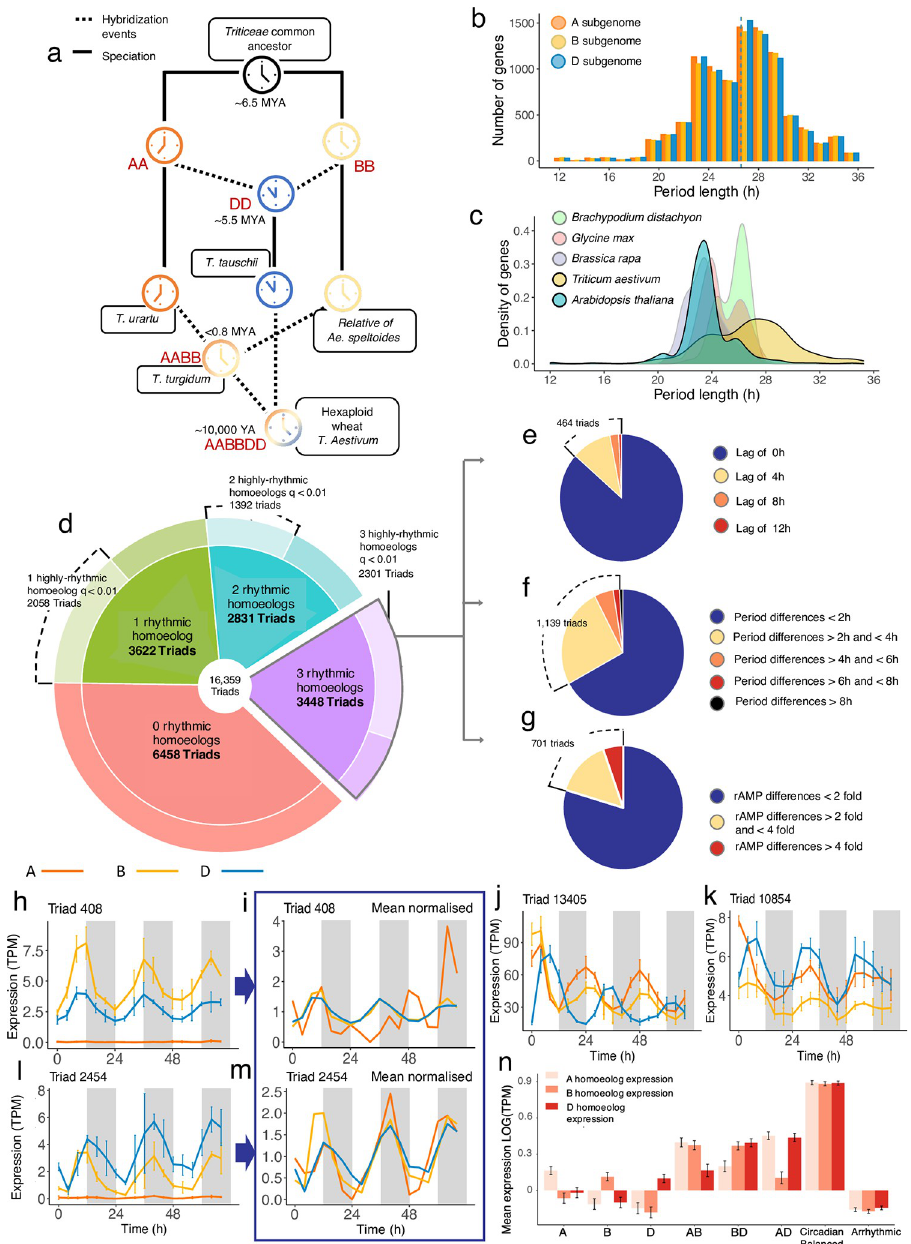
Fig 1. Circadian regulation of homoeolog expression of wheat triads. (a) Circadian clocks evolved independently in the ancestors of hexaploid wheat following divergence from a common ancestor approximately 6.5 million years ago. Colours of clock icons represent theoretical differences in clock regulation integrated in the tetraploid and hexaploid hybrids either through circadian balance or through dominance of a particular homoeolog copy. Speciation and hybridisation event dates are based on estimates from [115]. (b) Histogram showing distribution of period lengths in wheat split between the A, B, and D subgenomes. Periods were measured from 24–68 h data. Dotted line indicates the mean period for the A, B, and D subgenomes. (Data_Fig 1b in S1 Data). (c) Density plot showing the distribution of period lengths across rhythmic transcripts (BH q < 0.01) in Arabidopsis , Brassica rapa , Brachypodium distachyon , Glycine max (soybean), and wheat based on meta2d estimates on 24–68 h data following transfer to constant light. (Data_Fig 1c in S1 Data). (d) Proportions of triads with either 0 (red segment), 1 (green segment), 2 (blue segment), or 3 (purple segment) rhythmic gene(s) out of the 16,359 expressed triads in this dataset. Lighter shading in the outer segments represents cases where 1/2 homeolog(s) have high confidence rhythmicity (BH q < 0.01) alongside an arrhythmic homeolog (BH q > 0.05). We term these genes “imbalanced rhythmicity” triads. Triad differences are based on meta2d estimates from data 0–68 h after transfer to L:L. Of the 3,448 triads with 3 rhythmic